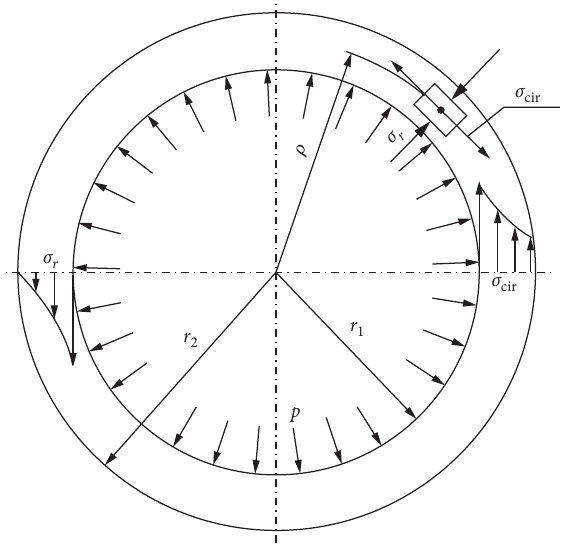
Figure 5: Scheme for the calculation of stresses in the hardened